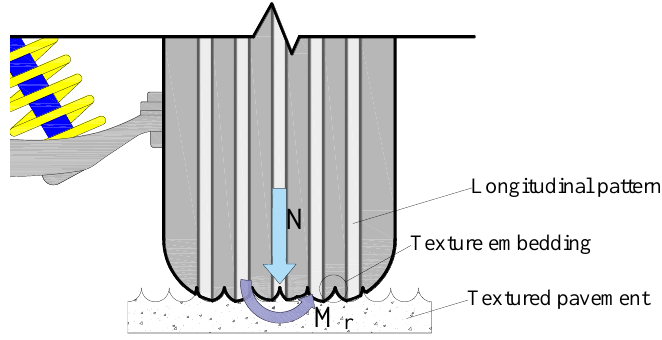
Figure 6. The meshing effect: N is vertical load; Mr is stationary steering resistance torque. The stationary steering resistance torque was calculated by the effective contact areas and the actual contact stress distribution. The calculation of the microelement of the stationary steering resistance torque at the center of the contact interface is expressed in Equation (8).